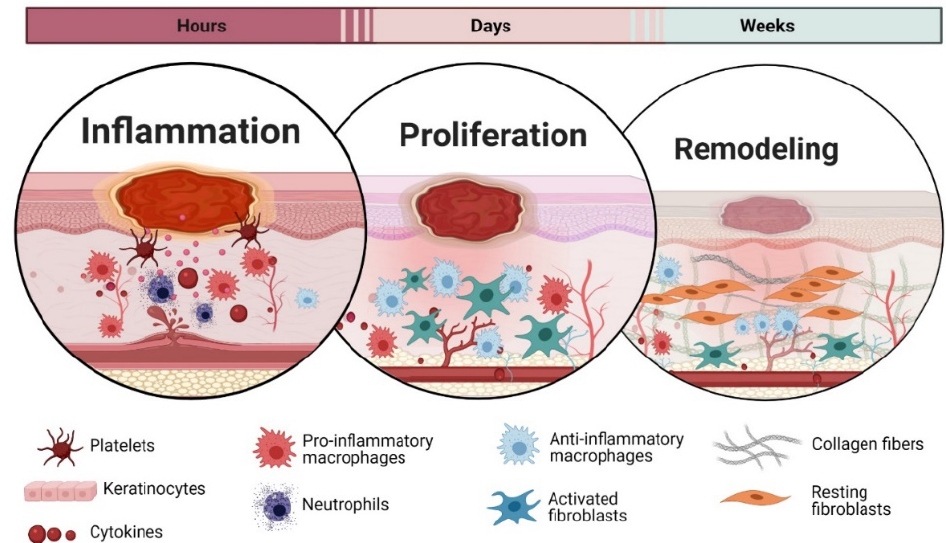
Figure 2. Wound healing phases. The timeline and overview for the healing phases also shows the involvement of the key cellular populations involved in the different phases.